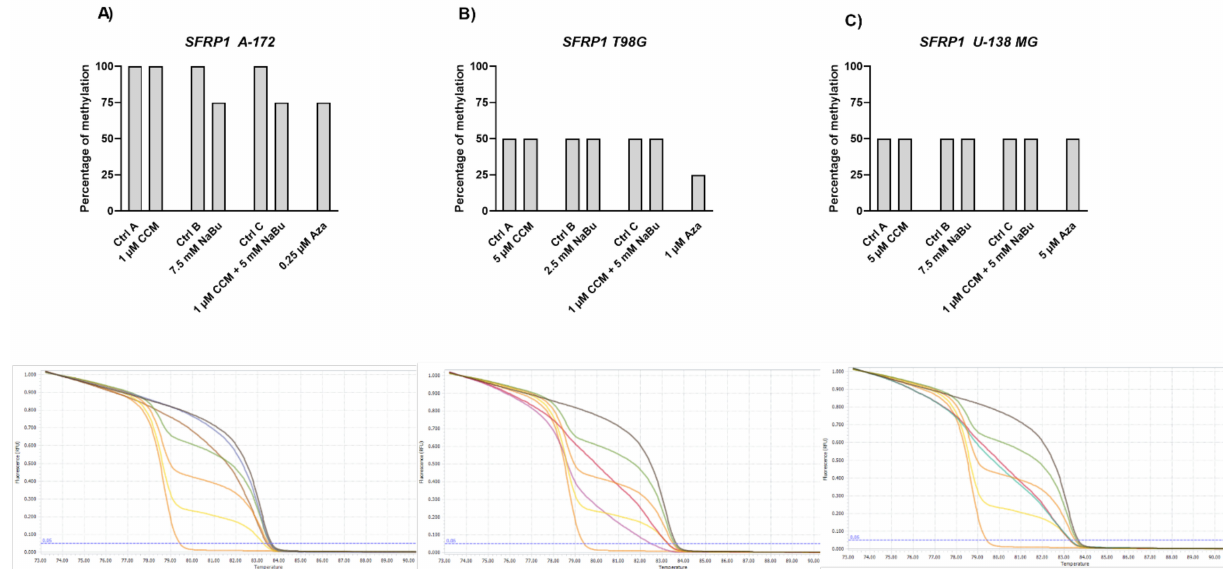
Figure 10. Results of MS-HRM analysis with representative melting curves of SFRP1 promoter methylation in A-172 ( A ), T98G ( B ), and U-138 MG ( C ) cell lines. Cells treated with vehicle (DMSO, PBS or both) are designated as Ctrl A, Ctrl B, and Ctrl C, respectively. Due to semiquantitative nature of generated results, no SEM bars are shown. Below each bar chart melting curves of control and best demethylating compound/combination are presented, together with subsequent controls: 100%, 75%, 50%, 25%, and 0% methylated controls (dark brown, green, honey yellow—middle line, bright yellow, and honey yellow—lower line, respectively). For A-172 cell line, melting curve generated after treatment with 1 µ M CCM + 5 mMNaBu mix is presented (mustard brown line, crossing the 75% green line) regarding Ctrl A (blue). For T98G cell line, Aza is presented (pink) in relation to Ctrl A (red). In case of U-138 MG cell line, 5 µ M CCM is shown (green) regarding Ctrl A